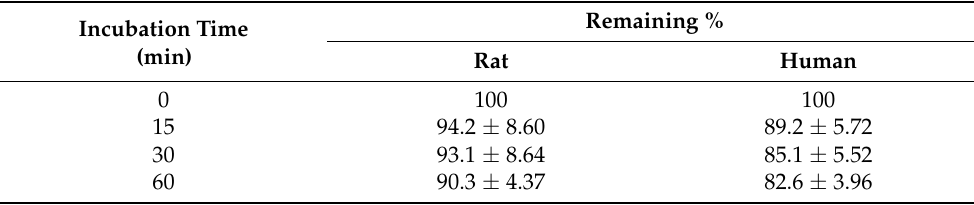
Table 4. Remaining % of α -amanitin in rat and human liver